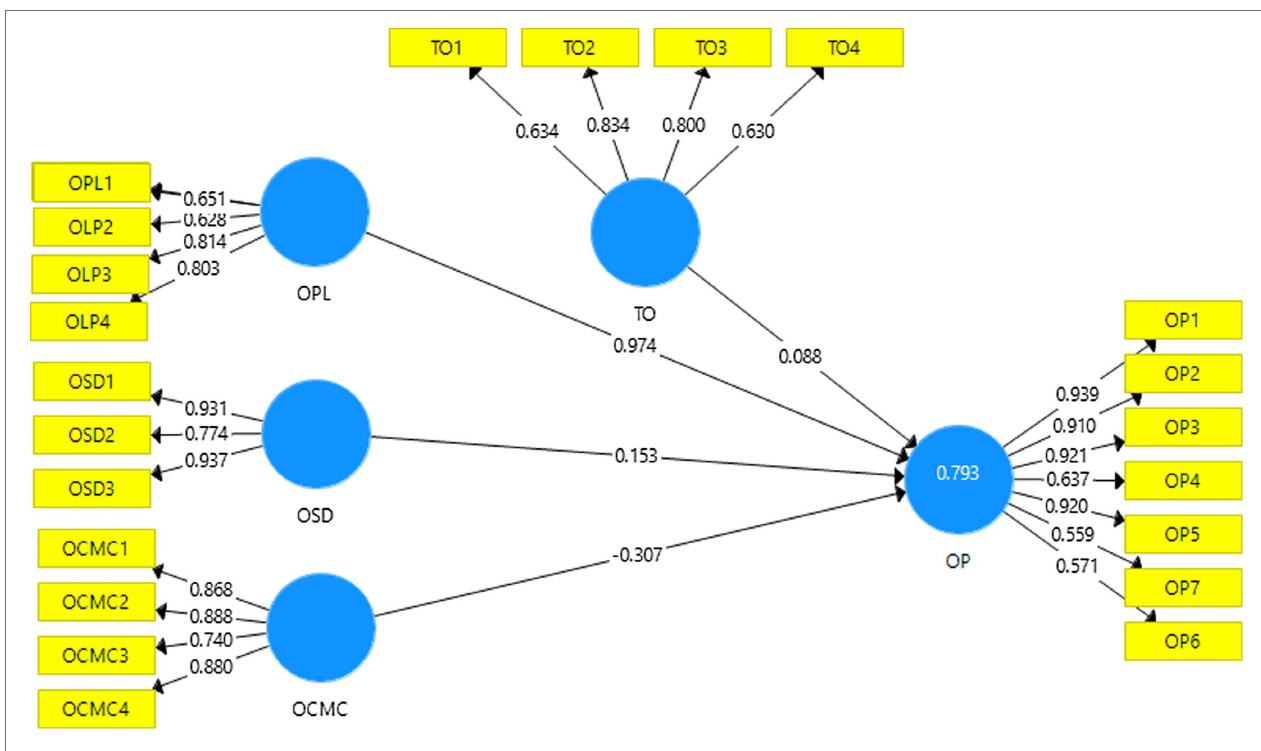
FIGURE 1 | Measurement